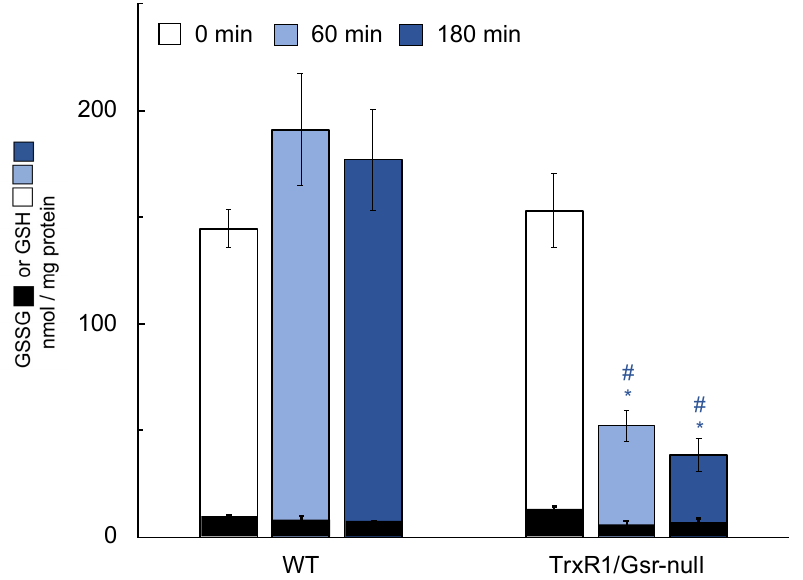
Figure 4. Hepatic levels of GSH and GSSG following short-term ascorbate treatment. Mice received a single dose of 4 mg/g ascorbate and were harvested at the indicated times thereafter (0 min mice received no ascorbate). n ≥ 5 animals for each condition. Green denotes GSH; black denotes corresponding GSSG in the same sample. Bars mean ± s.e.m.; *, p ≤ 0.05 versus untreated control of the same genotype; #, p ≤ 0.05 versus WT under same treatment using one-way ANOVA and Tukey–Kramer post hoc, pair-wise comparison.